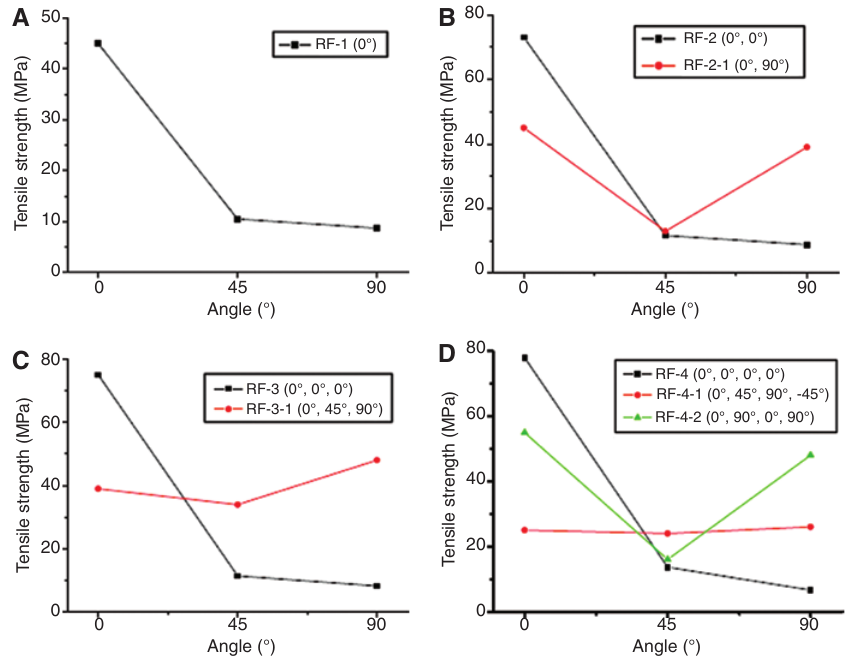
Figure 6: (A)–(D): Tensile strength at various angles of CR composites with different numbers of tire-cord layers and arrangement